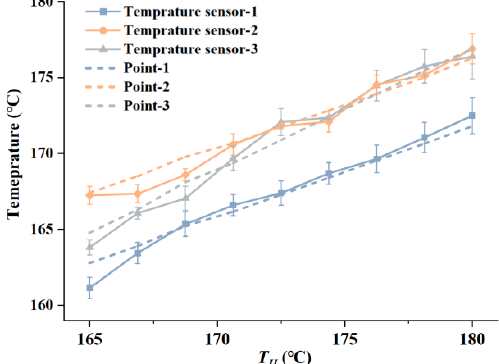
Figure 8. Temperature measurements and calculation results.